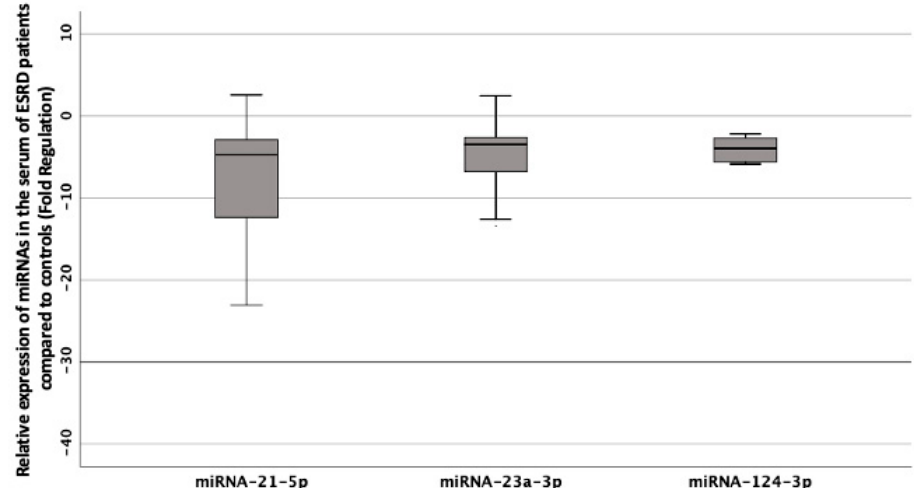
Figure 1. Box plot of the relative expression of the circulating miRNA-21-5p, miRNA-23a-3p, and miRNA-124-3p in cases compared to controls. Values are expressed as gene fold regulation and are displayed in a standardized way ( n = 30; 25th percentile; median; 75th percentile,). The error bars are showing the minimun and the maximum values. miRNA, microRNA Within the group of cases, miRNA-23a-3p was significantly and inversely correlated with TBS (rho = − 0.503, p = 0.005), and this correlation remained robust when adjusted for the parameters of Ca metabolism and BMD values (beta = − 0.221, p = 0.003, 95% CI − 0.360, − 0,081). BMD values at right femoral neck (RFN) and left femoral neck (LFN) but not LS were also significantly correlated with the relative expression of miR-124-3p (Figure 2A,B), but these associations did not remain significant after adjusting with the parameters of calcium